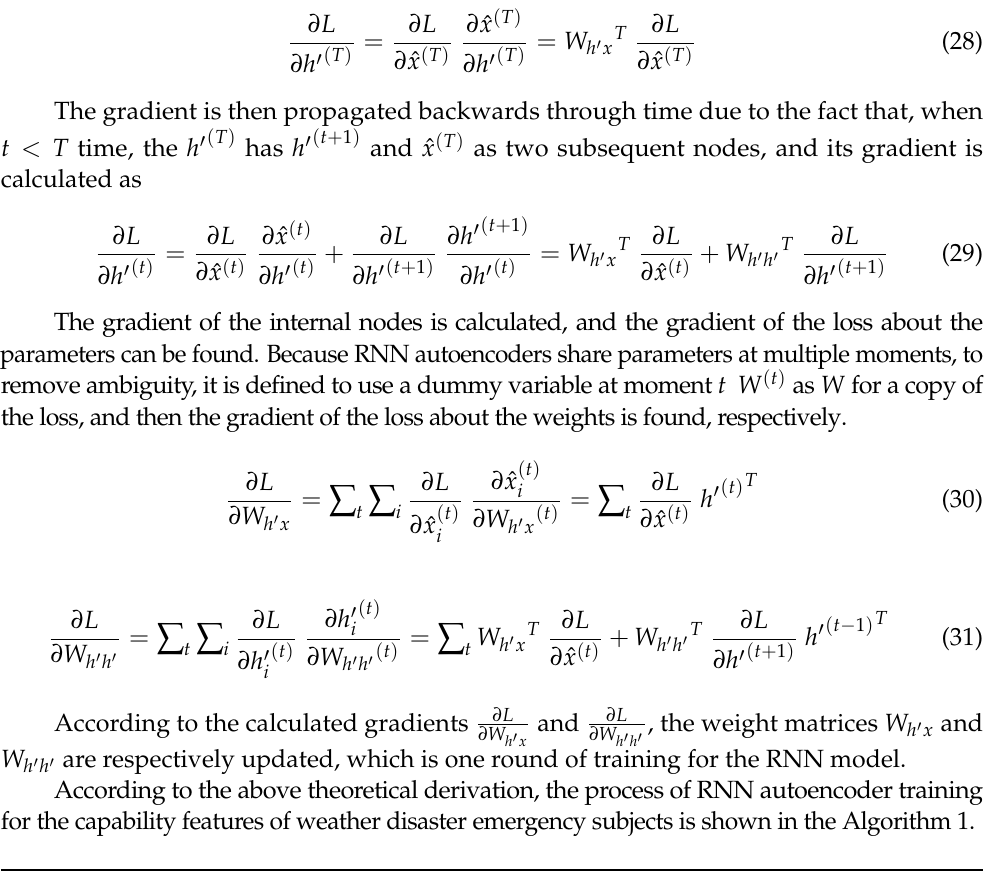
Algorithm 1. RNN autoencoder training